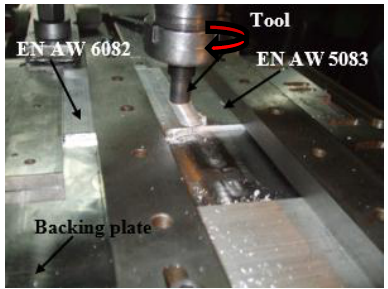
Table 4. FSW experimental layout with responses (UTS, ε, %).